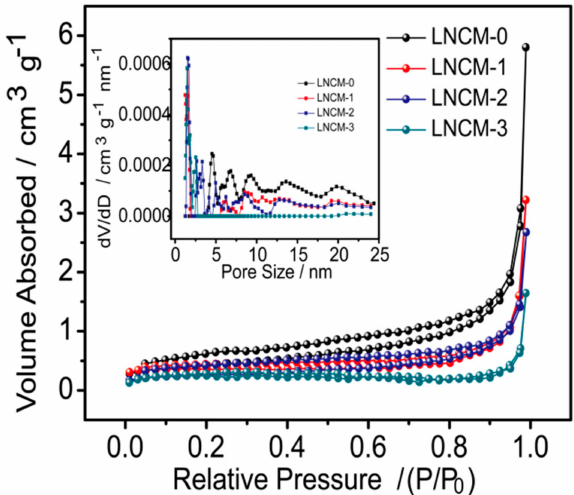
Figure 3. BET: nitrogen adsorption–desorption isotherms of